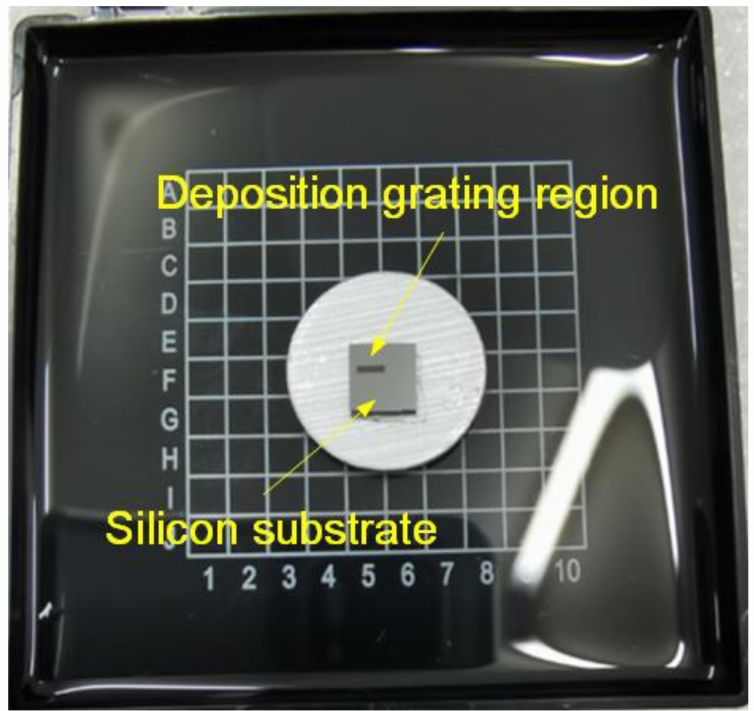
Figure 12. The atomic deposition grating sample.